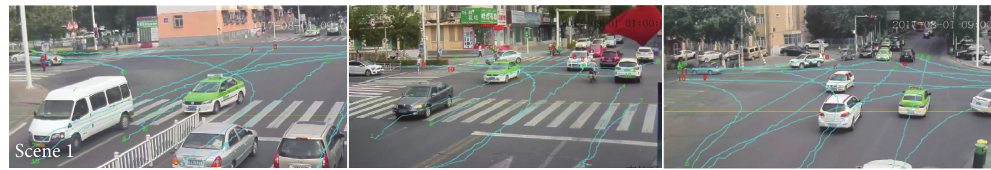
Figure 12: Three intersections in our experiments.